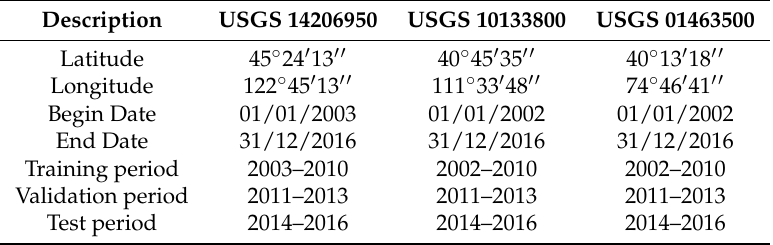
Table 1. Geographical information and division of historical data into the training, validation, and testing